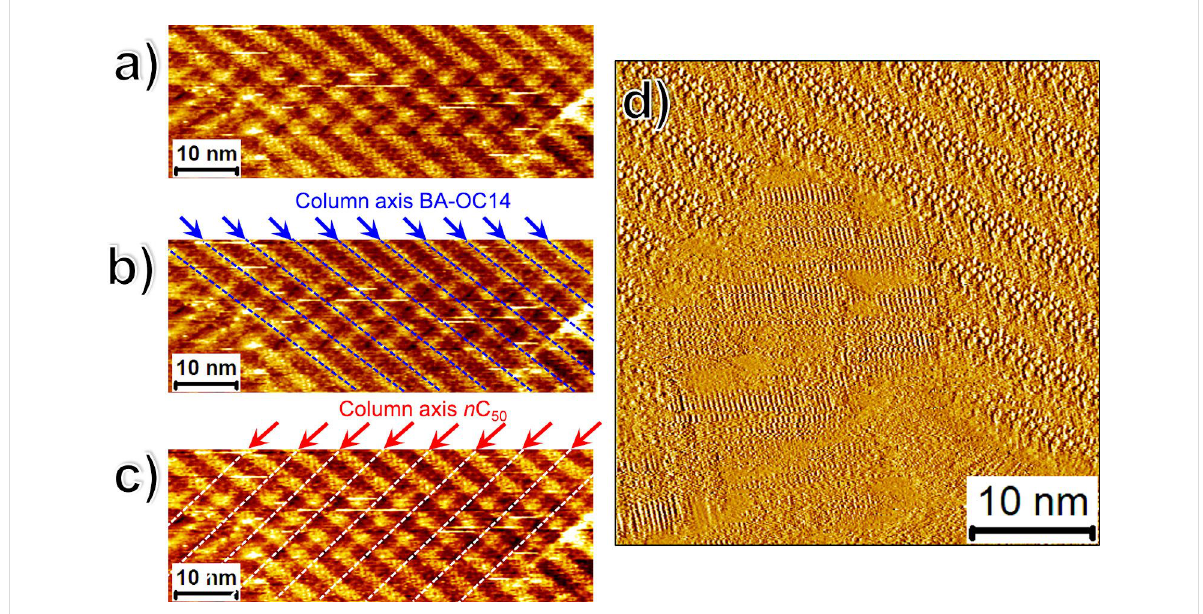
Figure 5: (a) STM image showing the superposition of the n -C 50 lamellae with those of BA-OC 14 confirming the bilayer structure of the system. Panels (b) and (c) show the same STM image with colored markers to aid the eye to identify the superimposed STM contrast arising from the columns of benzoic acid (blue dotted lines) and those of pentacontane (white dotted lines) running underneath. For the corresponding large-scale image see Figure S5 in Supporting Information File 1. Imaging conditions: I set = 130 pA, V bias = − 0.65 V. (b) STM current image showing the alignment of the chains of the tetradecyloxy chains of BA-OC 14 with the long axes of n -C 50 molecules. Imaging conditions: I set = 90 pA, V bias = − 0.17